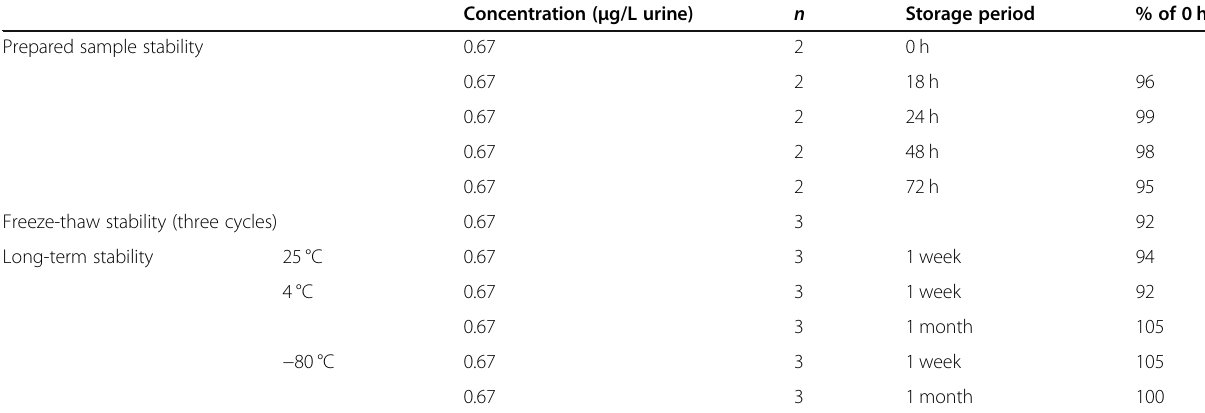
Table 5 Glyphosate stabilities in urine